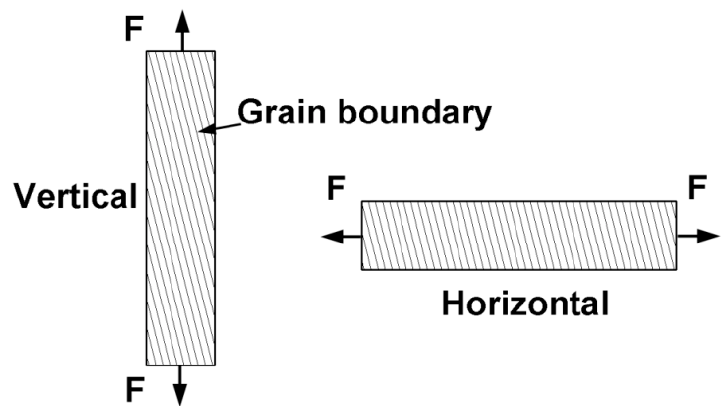
Figure 13. Schematic illustrations of the creep tensile load and grain boundaries for the vertical and horizontal specimens.